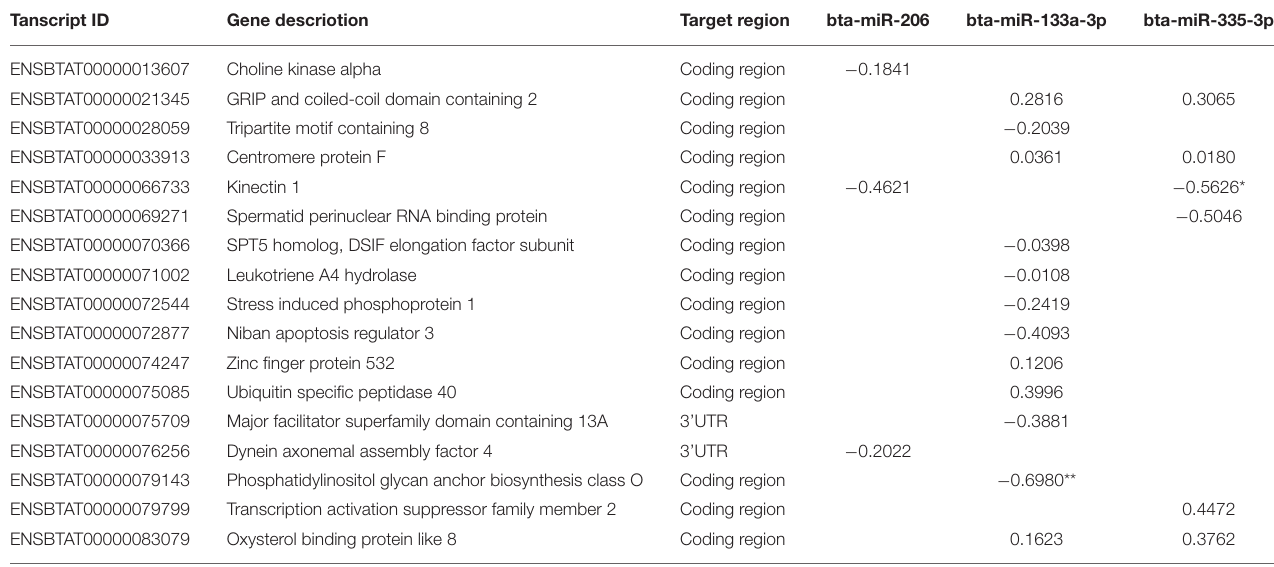
TABLE 5 | Spearman correlation coefficients between differencially expressed miRNA and